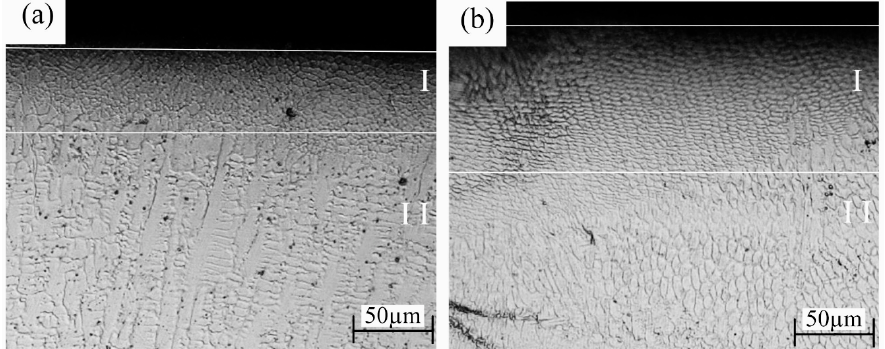
Figure 8. The metallographic images of the cross-sections of coating samples, ( a ) UB(FeCoNiCr), ( b ) UB(CoCrNi).